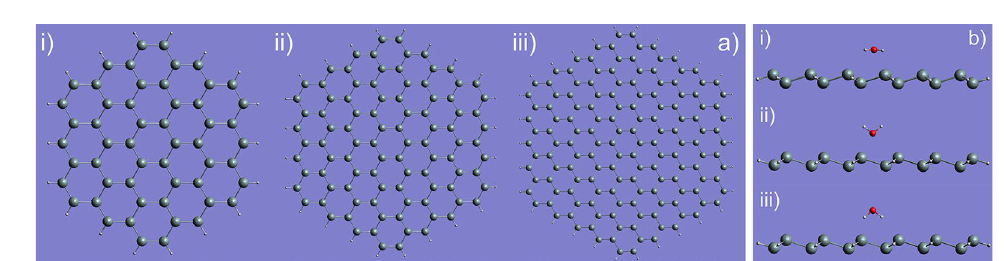
Figure 2. ( a ) The initial structures for the SNDs with different sizes. (i) 3 × 3 , (ii) 4 × 4 ; and (iii) 5 × 5 . ( b ) The water molecules with three different initial orientations were put on the 3 × 3 SND (and the other two SNDs as well, not shown here). (i) is the lying-down configuration, (ii) standing-up (zero-leg), and (iii) standing-up (two-leg). The different distances of 1, 2, and 3 angstroms (near, moderate, and far) were considered, which are close to the Si–O bond length (~ 1.5 angstroms).